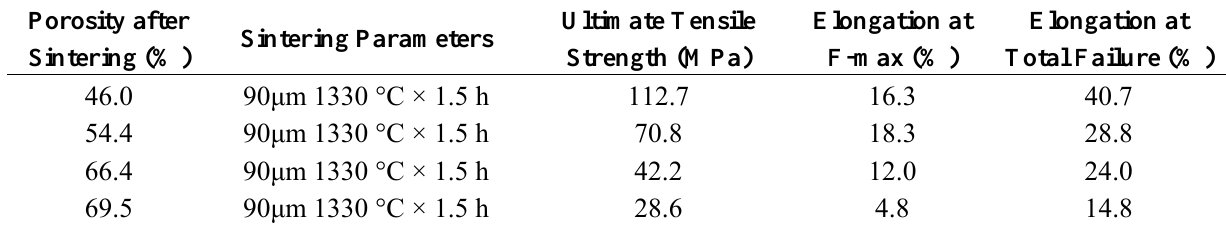
Table 2. Summary of the tensile properties of the PTWMs with different